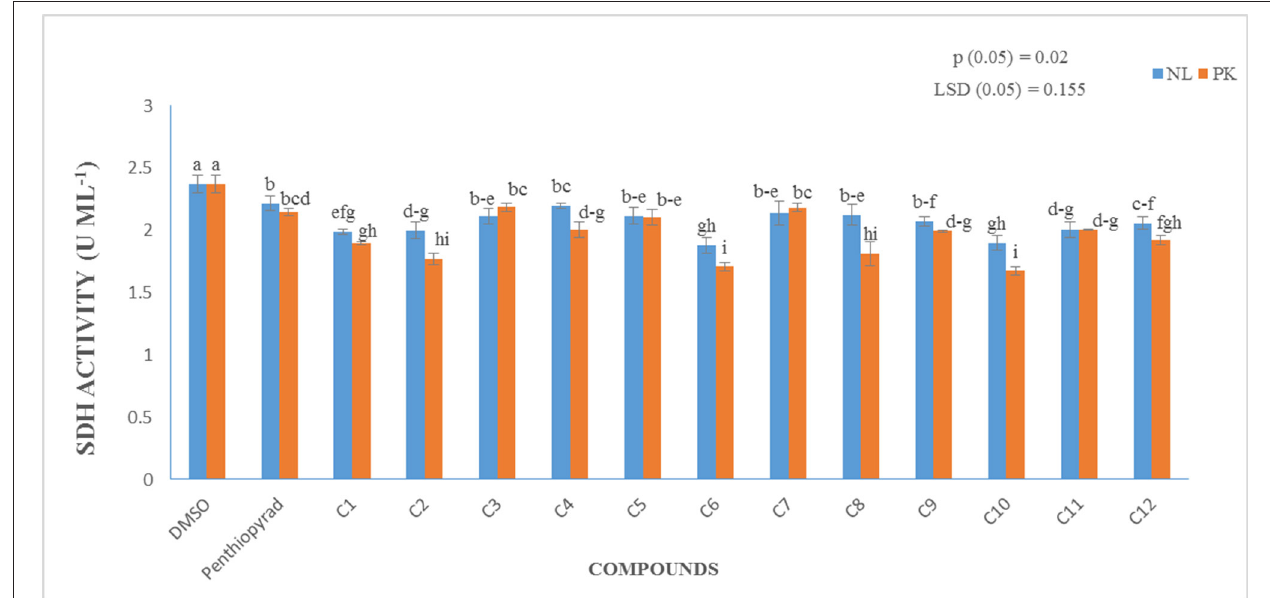
FIGURE 7 | Measurement of Succinate Dehydrogenase Activity ( in vitro ) of 12 SDHIs.